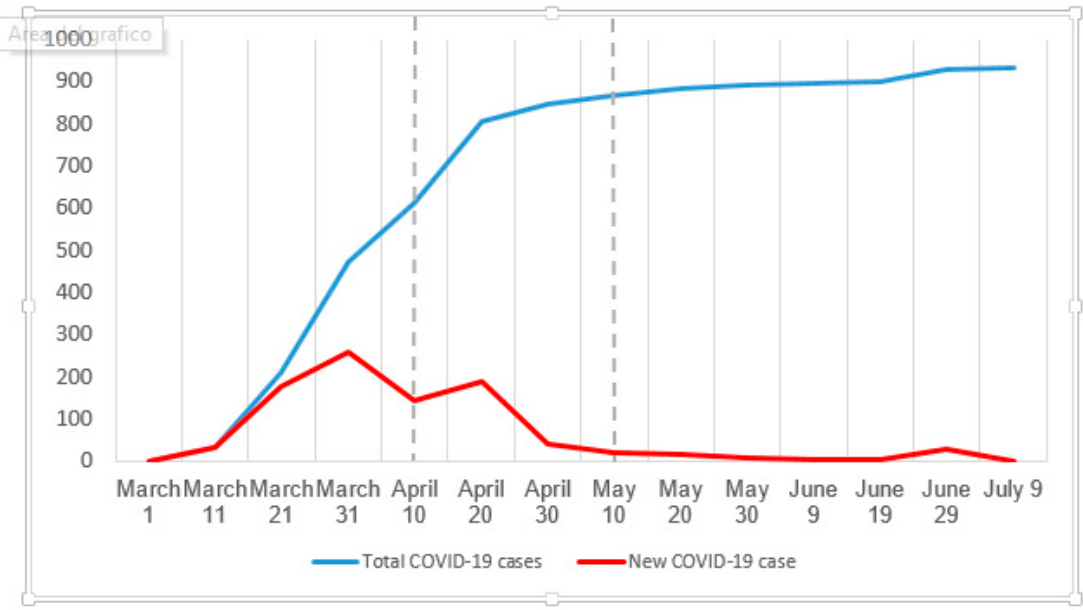
Figure 2. Case count (unit) of COVID-19 infection in Pisa (Italy) before, during, and after the study